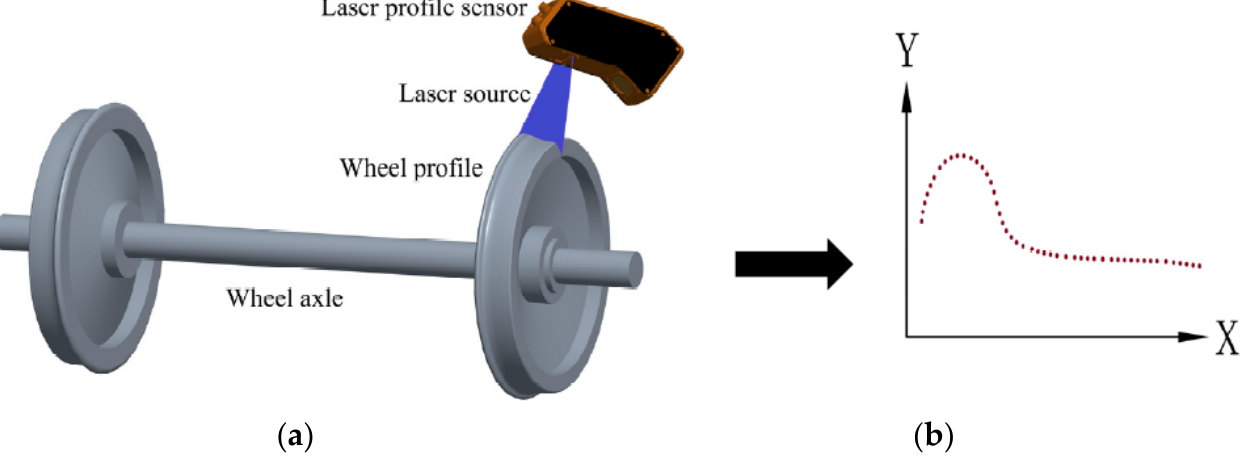
Figure 3. The procedure for measuring wheel profile radius of curvature.